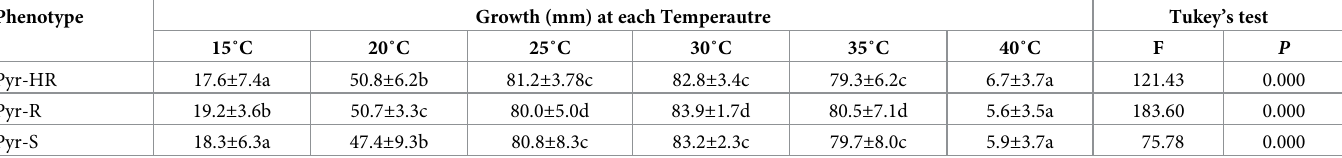
Tukey’s test. S = sensitive, R = resistant, and HR = high